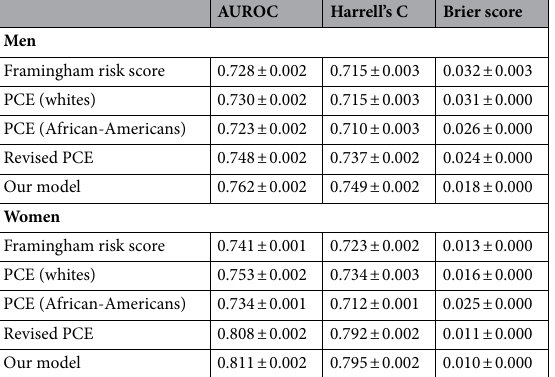
Table 3 summarizes the performance of the CVD risk pre- diction model for both sexes. The sex-specific prediction model performed well on both model discrimination parameters. The average Harrell’s C in the validation for our model was 0.749 ± 0.002 in men and 0.795 ± 0.002 in women. The cross-validation results of the AUROC are shown in Fig. 1. Compared to the AUROC of the revised PCE, the AUROC of our model improved from 0.748 ± 0.002 to 0.762 ± 0.002 in men and from 0.808 ± 0.002 to 0.811 ± 0.002 in women. For comparison, other models had an AUROC ranging from 0.723 ± 0.002 to